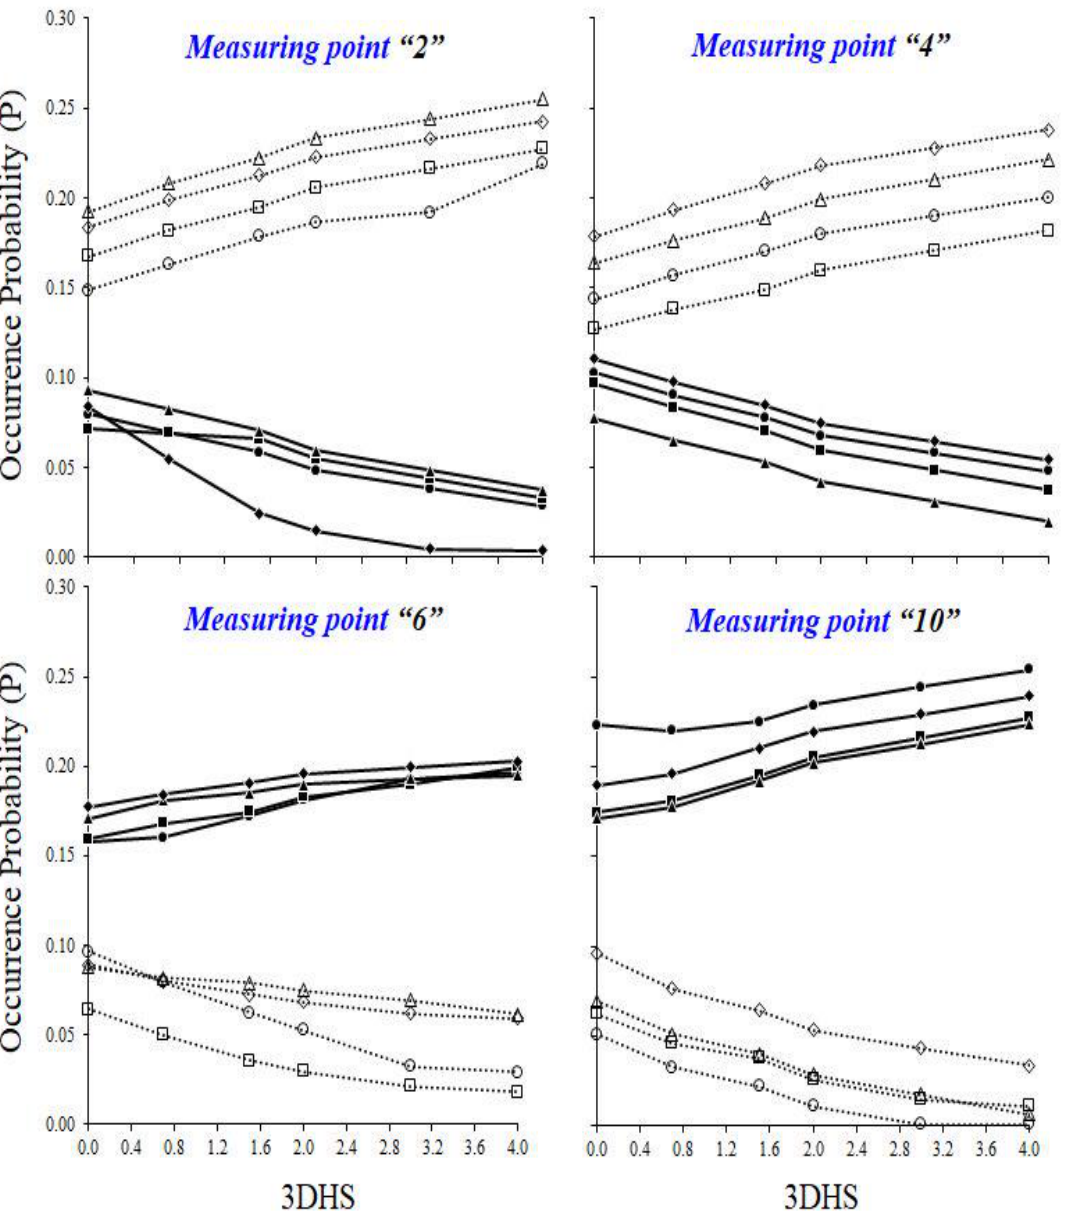
Figure 15. Depth-averaged occurrence probabilities of the octagonal bursting events with 3DHS values for the experimental run 6R: P 1 (filled circles), P 2 (unfilled circles), P 3 (filled squares), P 4 (un- filled squares), P 5 (filled triangles), P 6 (unfilled triangles), P 7 (filled diamonds), and P 8 (unfilled dia- monds). Continuous lines indicate odd octagonal events, while dashed lines denote even events.